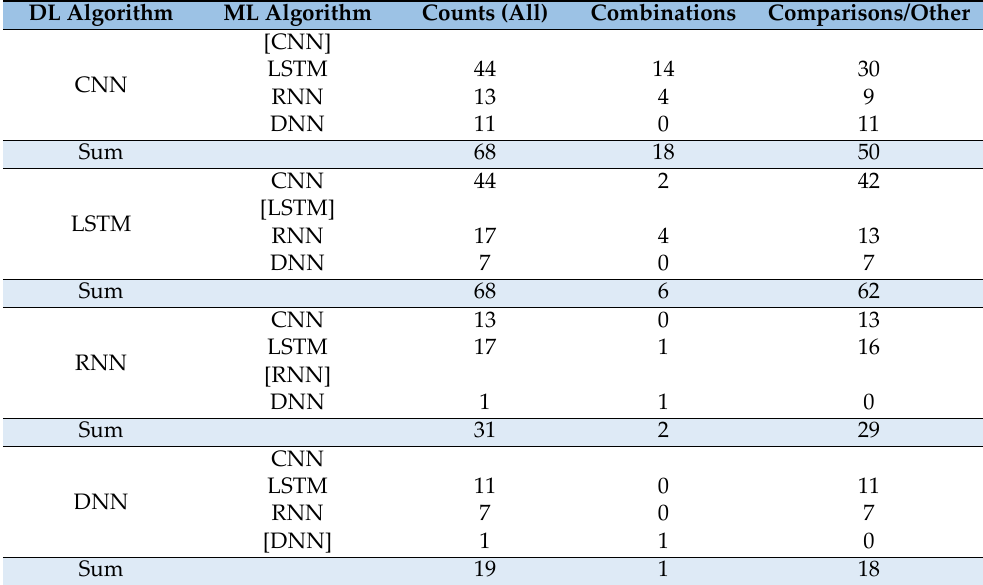
Table 2. Results of PubMed searches for combinations or comparisons of two DL algorithms (for abbreviations, see caption of previous table).